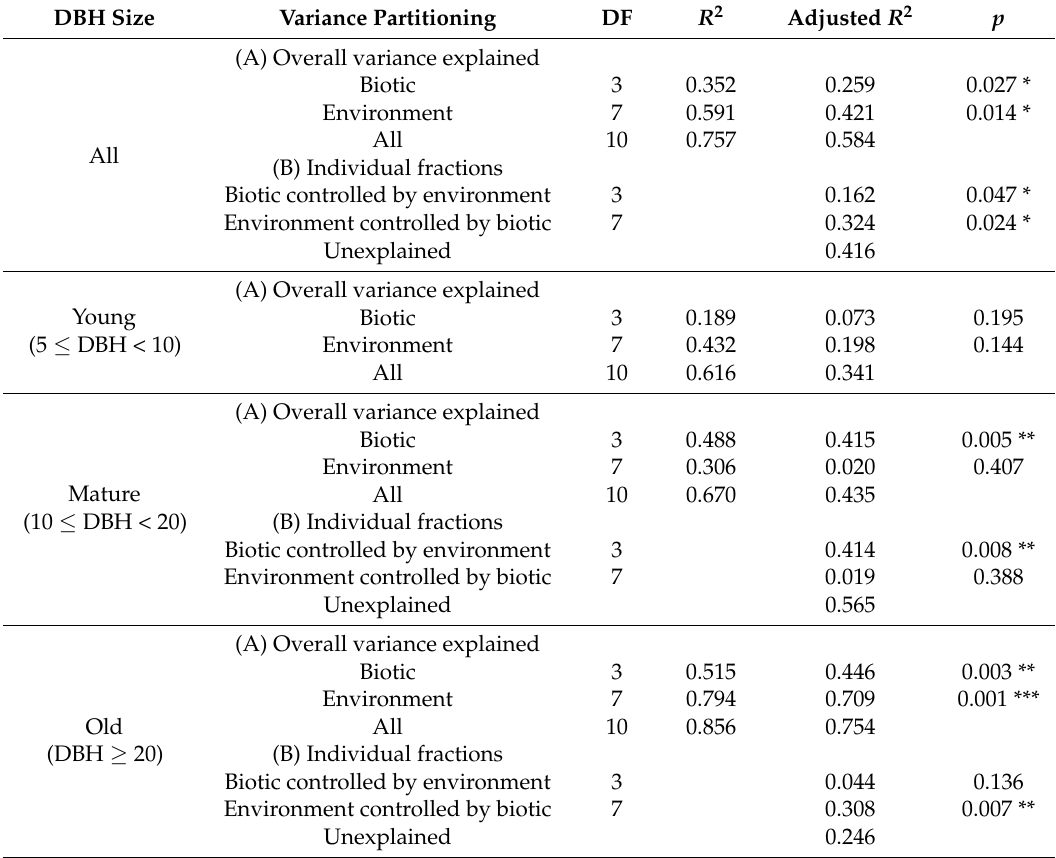
Table 3. (A) Overall variance explained; and (B) Variance partitioning results of the individual fractions. DBH Size Variance Partitioning DF R 2 Adjusted R 2